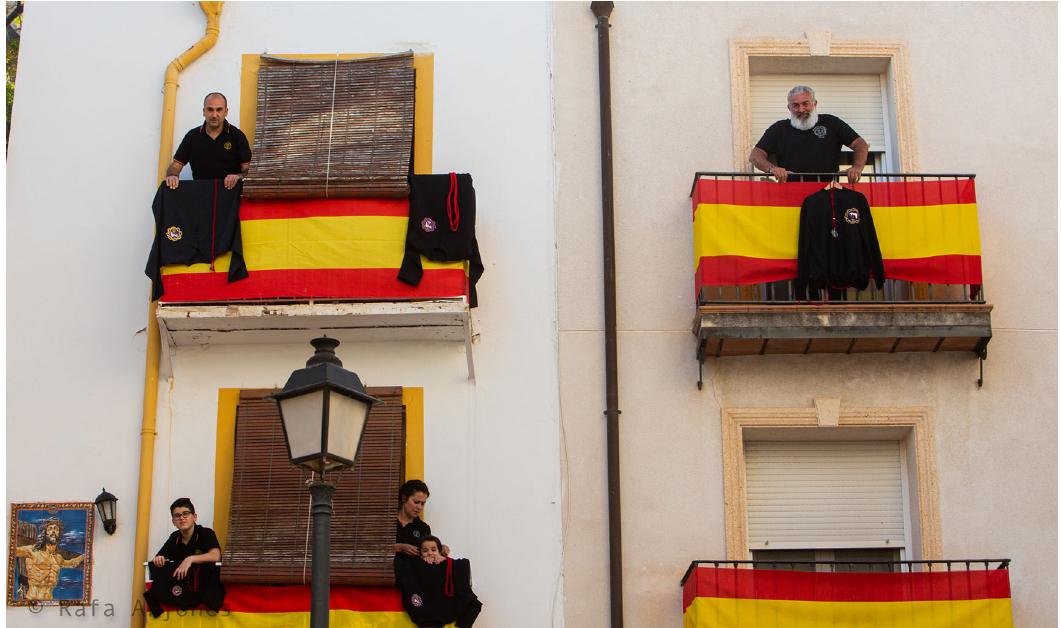
Figure 8. Facades of two buildings with four balconies adorned with the Spanish flag. The pandemic also increased certain patriotic spirit. After all, it was a symbolic war against the virus. This figure has been reproduced with kind permission of the